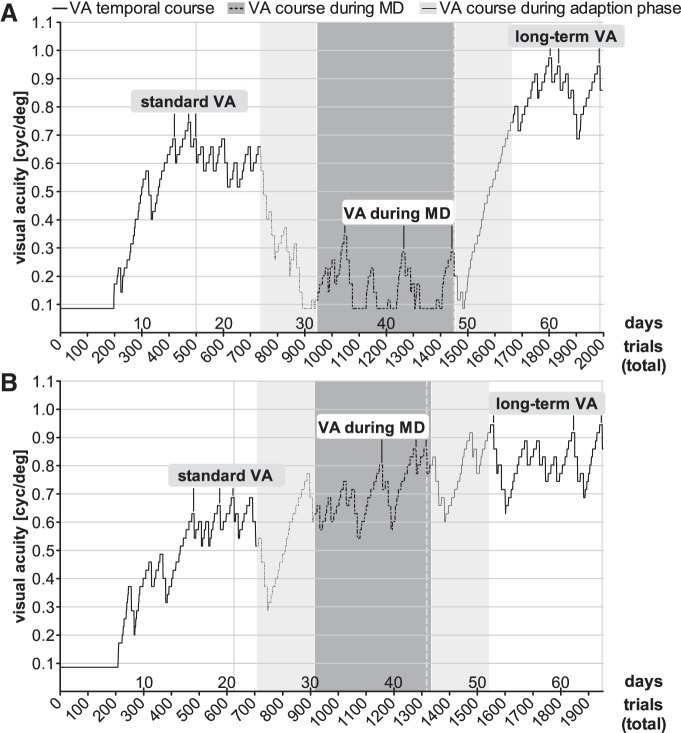
Extended monocular VWT training did not reliably increase VA, but long-term VWT training did. After determination of a standard VA, one eye was closed in animals of the VWT/MD group and mice were trained monocularly in the VWT. After an adaption phase of one week after MD (light gray background), a monocular VA (VA during MD) was determined (dark gray), then the previously closed eye was reopened, and binocular VWT training was continued (another 7 d adaption phase was introduced, light gray), until a long-term VA was determined (white). Note that individual mice (A, B) responded quite differently to MD. Data plotted as in Figure 2A.